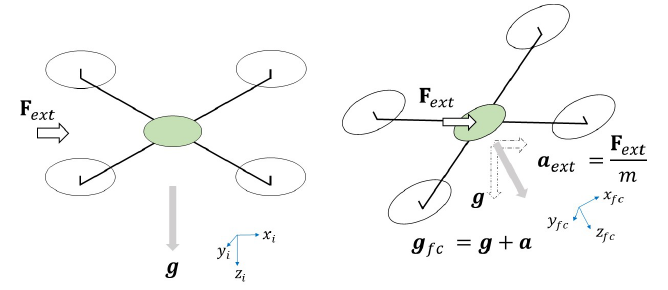
Figure 3. Force compensation